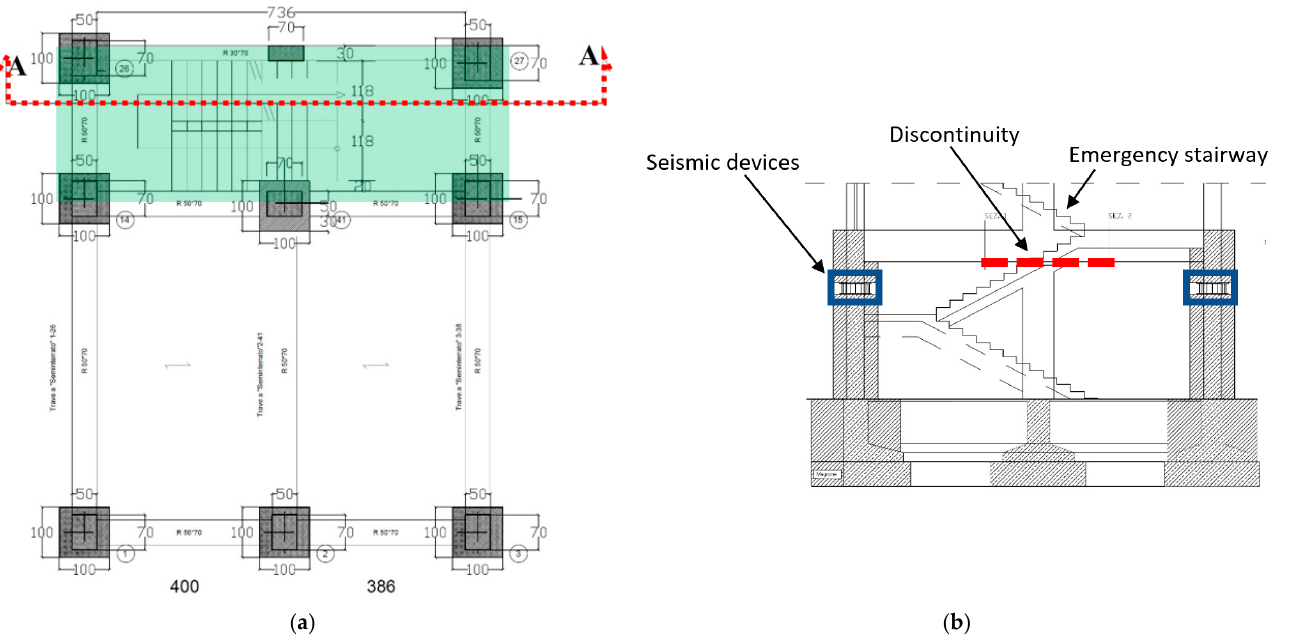
Figure 14. Detail of seismic joint in the region of emergency stairway: ( a ) plan view (dimensions in cm) and ( b ) vertical cross-section (detail of foundation